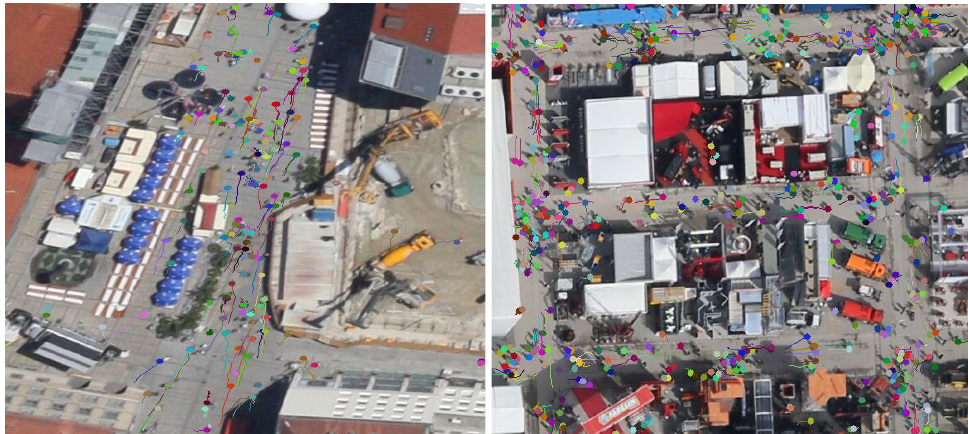
Figure 1. Multi-Pedestrian tracking results of AerialMPTNet on the frame 18 of the “Munich02” ( left ) and frame 10 of the “Bauma3” ( right ) sequences of the AerialMPT dataset. Different pedestrians are depicted in different colors with the corresponding trajectories.